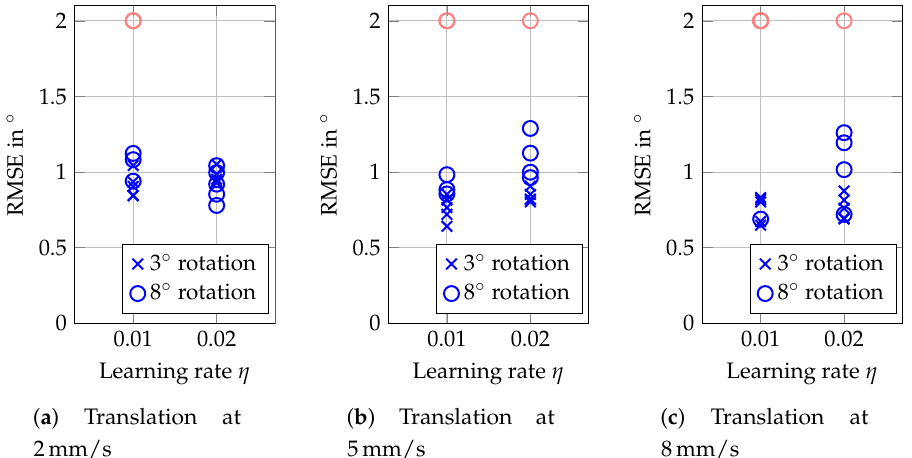
10mm 10mm cube at 8mm/s ( b ). × ×